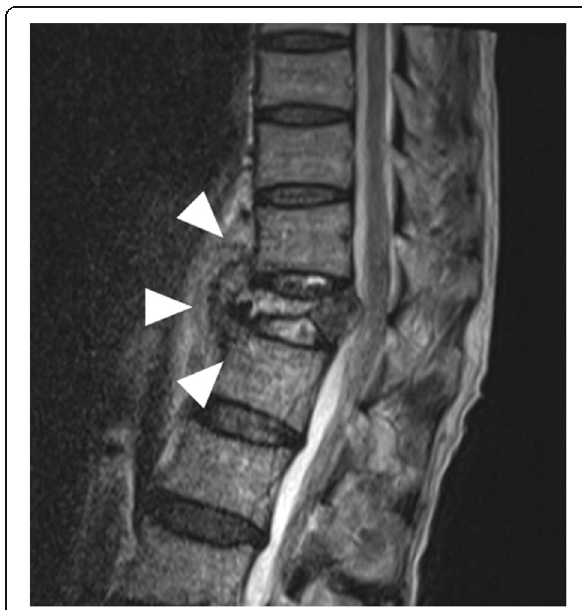
Fig. 1 Lumbar magnetic resonance imaging (MRI) on admission. MRI revealed a compression fracture of the 12th thoracic vertebral body and hematoma anterior to the vertebral body (white